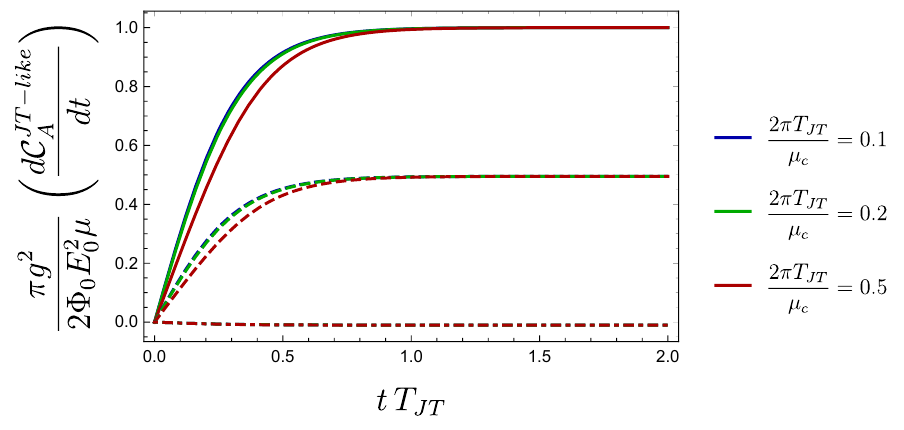
Figure 10 . Complexity growth in the dimensionally reduced model derived from the RN black holes with q m = 0, the \JT-like" model given by the action in eq. (4.26). We (cid:12)x the dimensionless ratios (cid:8) b = 10 (cid:0) 3 (cid:8) 0 , 4 (cid:25)L 2 = 10 (cid:0) 4 (cid:8) 0 , (cid:14)E = 0 : 01 E 0 and l = L 2 . The solid curves are the complexity ct 2 growth without the addition of the counterterm (cid:13) = 0, the dashed curves correspond to (cid:13) = 1 2 and the dot-dashed correspond to (cid:13) = 1 . As in the electrically charged black holes discussed in section 2, a higher value of the parameter (cid:13) decreases the late time growth of complexity for the \JT-like